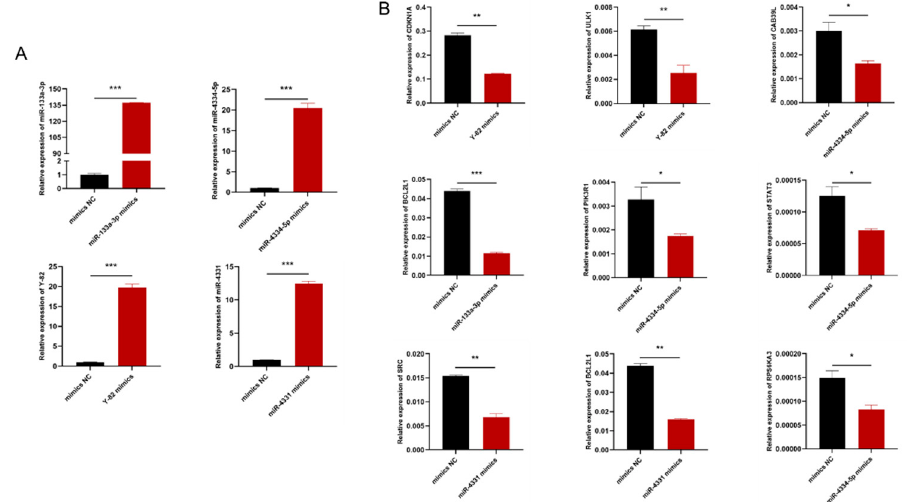
Figure 6. Expression levels of target genes after transfection of the potential miRNA mimics. ( A ) Efficiency of miRNA mimics after miRNA mimics transfection compared with that of the mimics negative control (NC). ( B ) The RNA level of target genes detected by qRT-PCR after the transfection of Y-82, miR-4334-5p, miR-4331, and miR-133a-3p mimics analyzed in the pituitary cell of Bama minipigs. (* p < 0.05, ** p < 0.01, *** p < 0.001.)